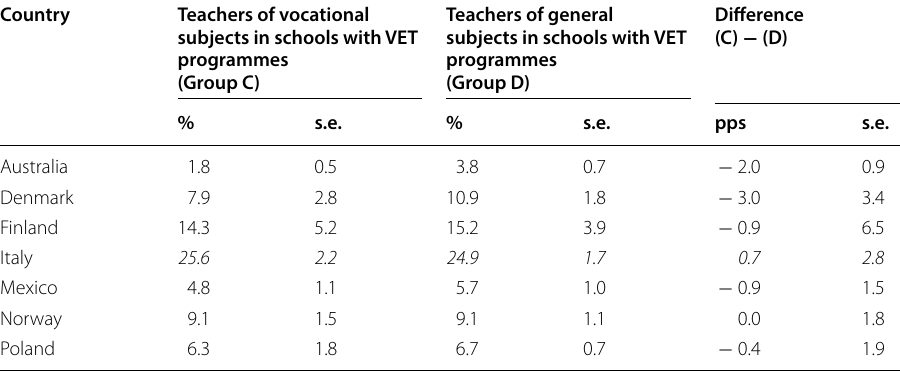
Table 4 Non participation in teachers’ professional development activities: differences between Group C and Group D of teachers, in percentage points (pps) and standard error of the difference (s.e.), 2013 (Source: Author’s calculations based on OECD, TALIS 2013)